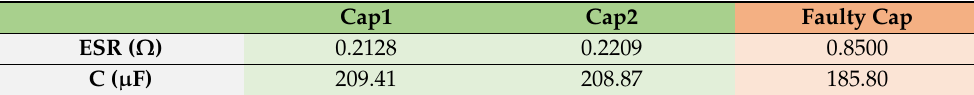
Figure 9. LED fixtures’ instantaneous currents I Rs1 and I Rs2 , showing the fault transience in the two capacitors (Cap1 and Cap2). The proposed FDA requires the capacitor’s voltage and current signals, obtained with an NI USB-6366 data acquisition card. For data acquisition, the sampling rate was set at 100 kHz. The STLSP method was developed in MATLAB code and placed into the Lab- VIEW program, through the MATLAB script node, for the online execution of the sug- gested FDA. The other steps in the proposed method, such as low-pass filtering and downsampling, were performed directly using the LabVIEW palettes.